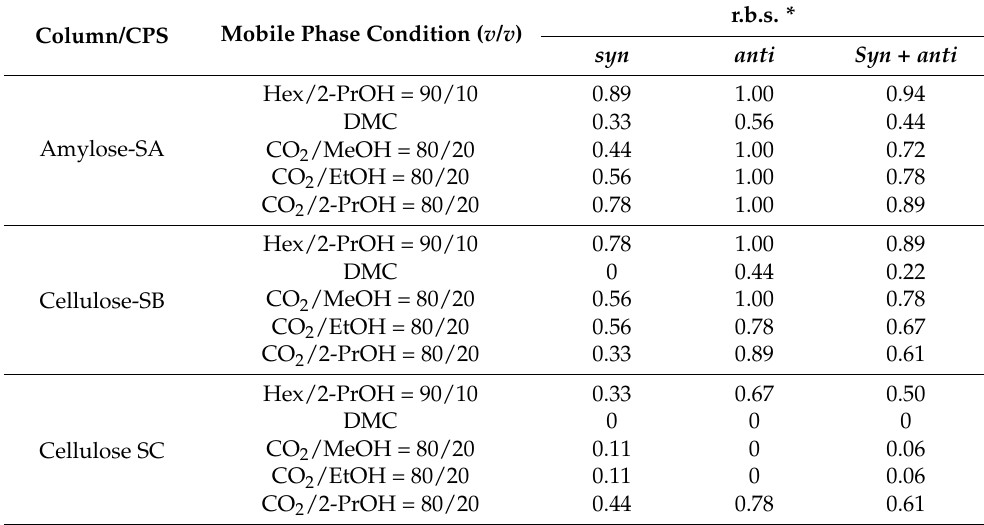
Table 4. Enantioseparation efficiencies of the three tested immobilized CSPs.